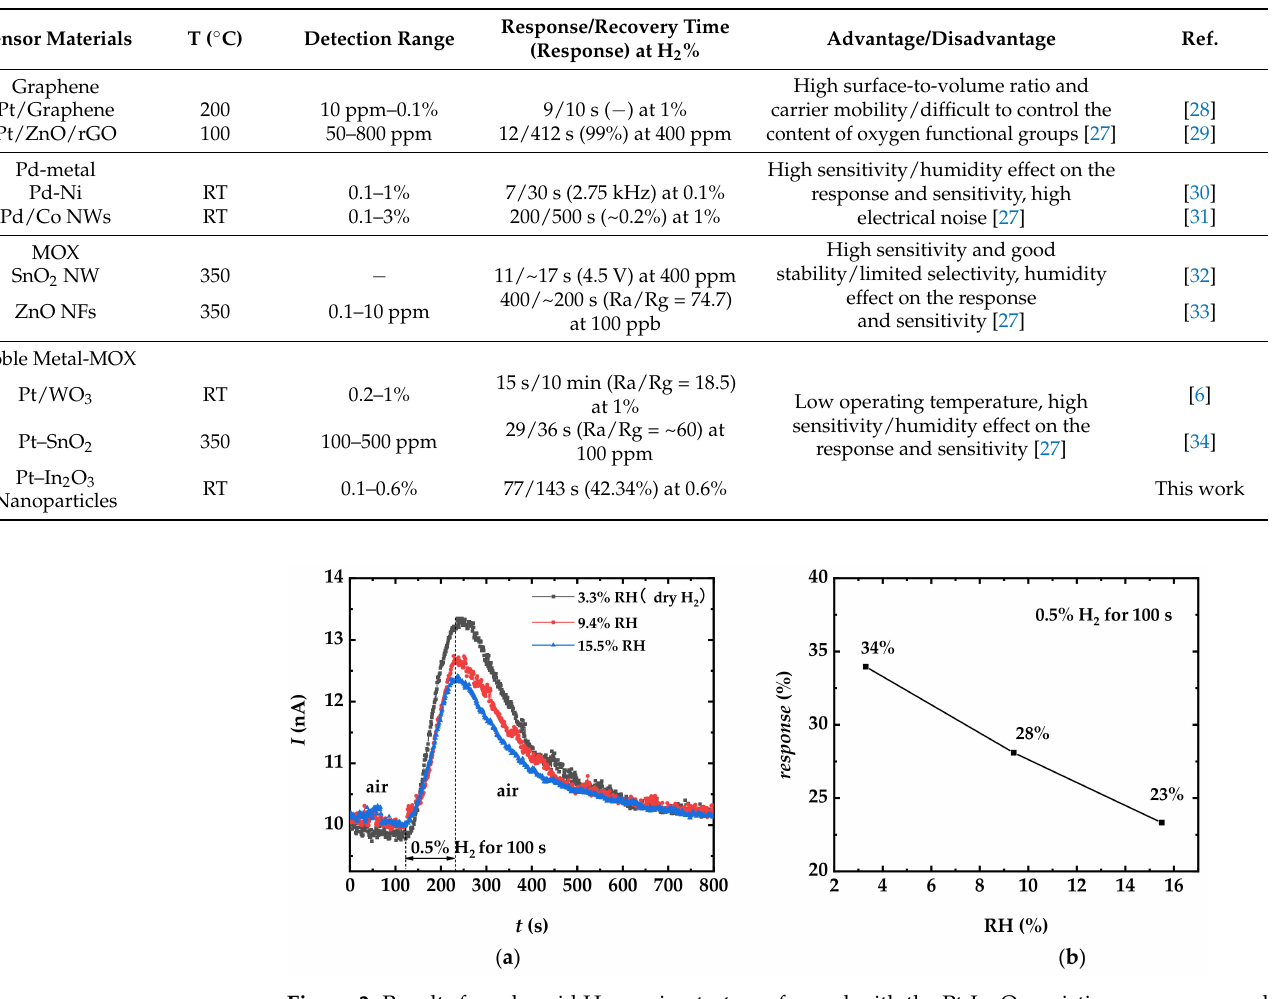
Figure 3. Results from humid H 2 sensing tests performed with the Pt-In 2 O 3 resistive sensor exposed to H 2 . ( a ) Dynamic response of the sensor towards 0.5% H 2 at 3.3% RH (corresponding to dry H 2 ), 9.4% RH, and 15.5% RH, respectively. The response decreases slightly with the increasing RH. ( b ) Sensor response as a function of RH for 0.5% H 2